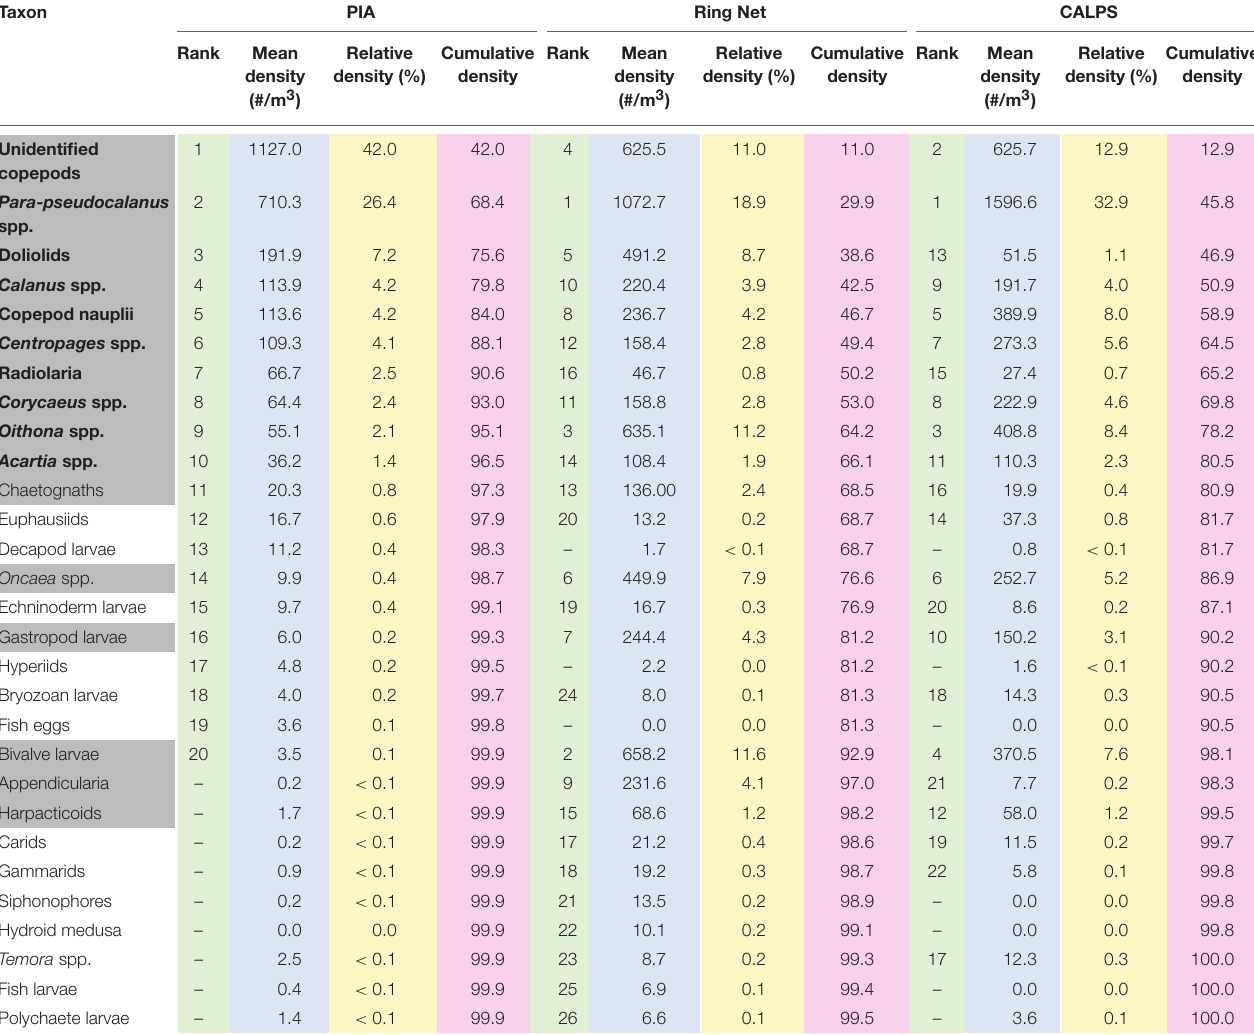
TABLE 1 | Average abundances and proportions of taxa collected by the PIA, CALPS, and Ring Net, across all stations. Taxon PIA Ring Net CALPS